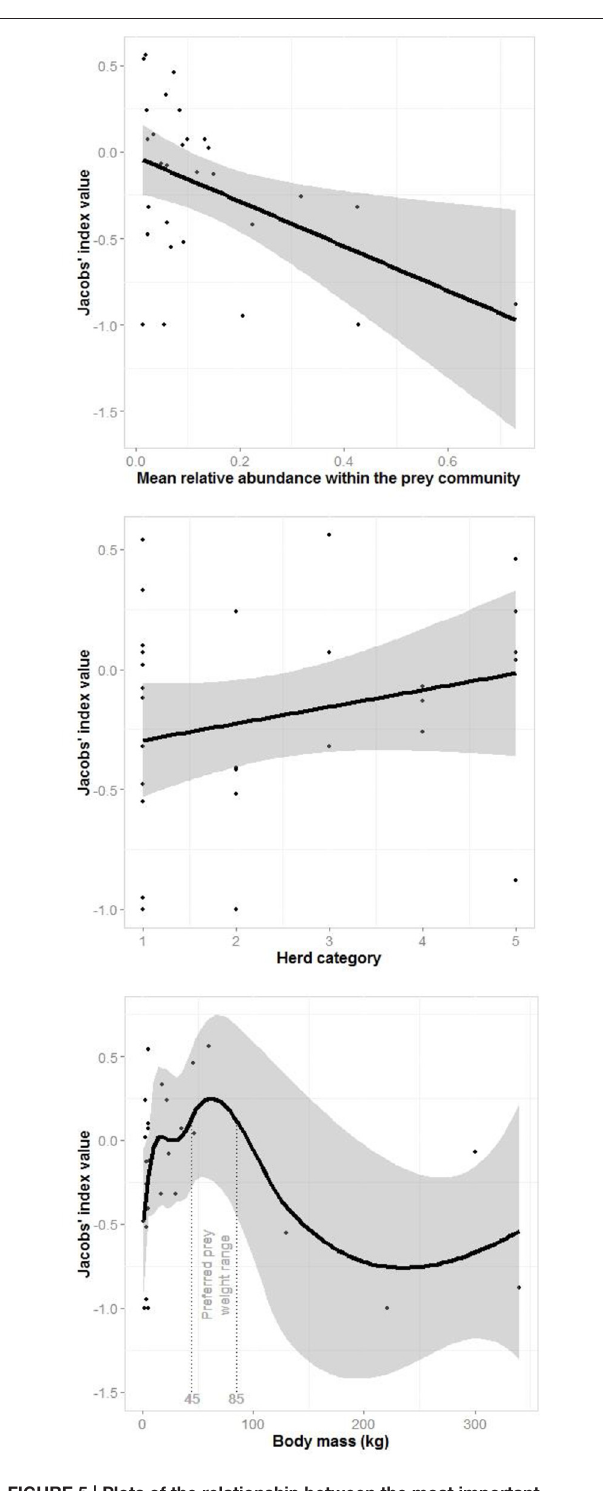
FIGURE 5 | Plots of the relationship between the most important drivers of jaguar prey selection based on the generalized linear model (Table 3): mean prey abundance (linear), prey herd category (1–solitary, 2–pairs, 3–small groups, 4–groups of 5–20, and 5 large groups; linear) and prey body mass (three-quarters of adult female body mass; loess smooth).